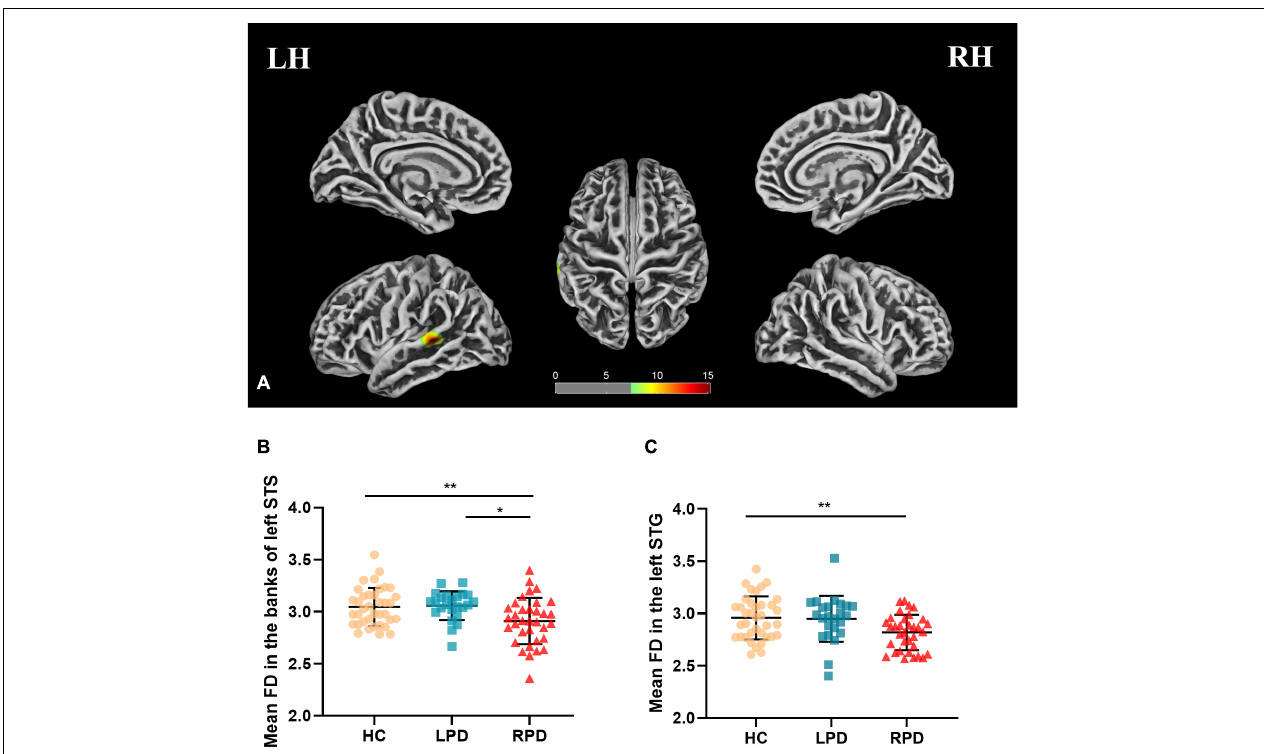
FIGURE 1 | (A) Mean fractal dimension (FD) analysis of the group effect are highlighted [ p < 0.05, familywise error (FWE) correction]. (B,C) Boxplots of the distribution of mean FD in the banks of the left superior temporal sulcus (STS) and left superior temporal gyrus (STG) among three groups ( post hoc p < 0.017, Bonferroni corrected). Post hoc analyses revealed significantly decreased mean FD in the bank of left STS in patients with right-onset of Parkinson’s disease (RPD) compared with HC (** p = 0.009) and left-onset of PD (LPD) (* p = 0.012). Patients with RPD showed decreased mean FD in the left STG compared with HC (* p =